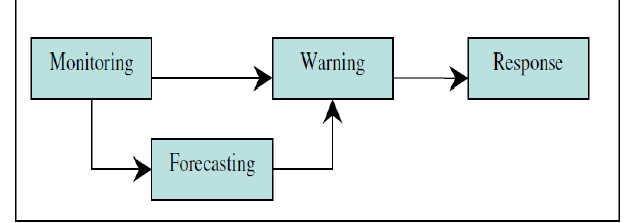
Figure 3: Main Components of an Early Warning System